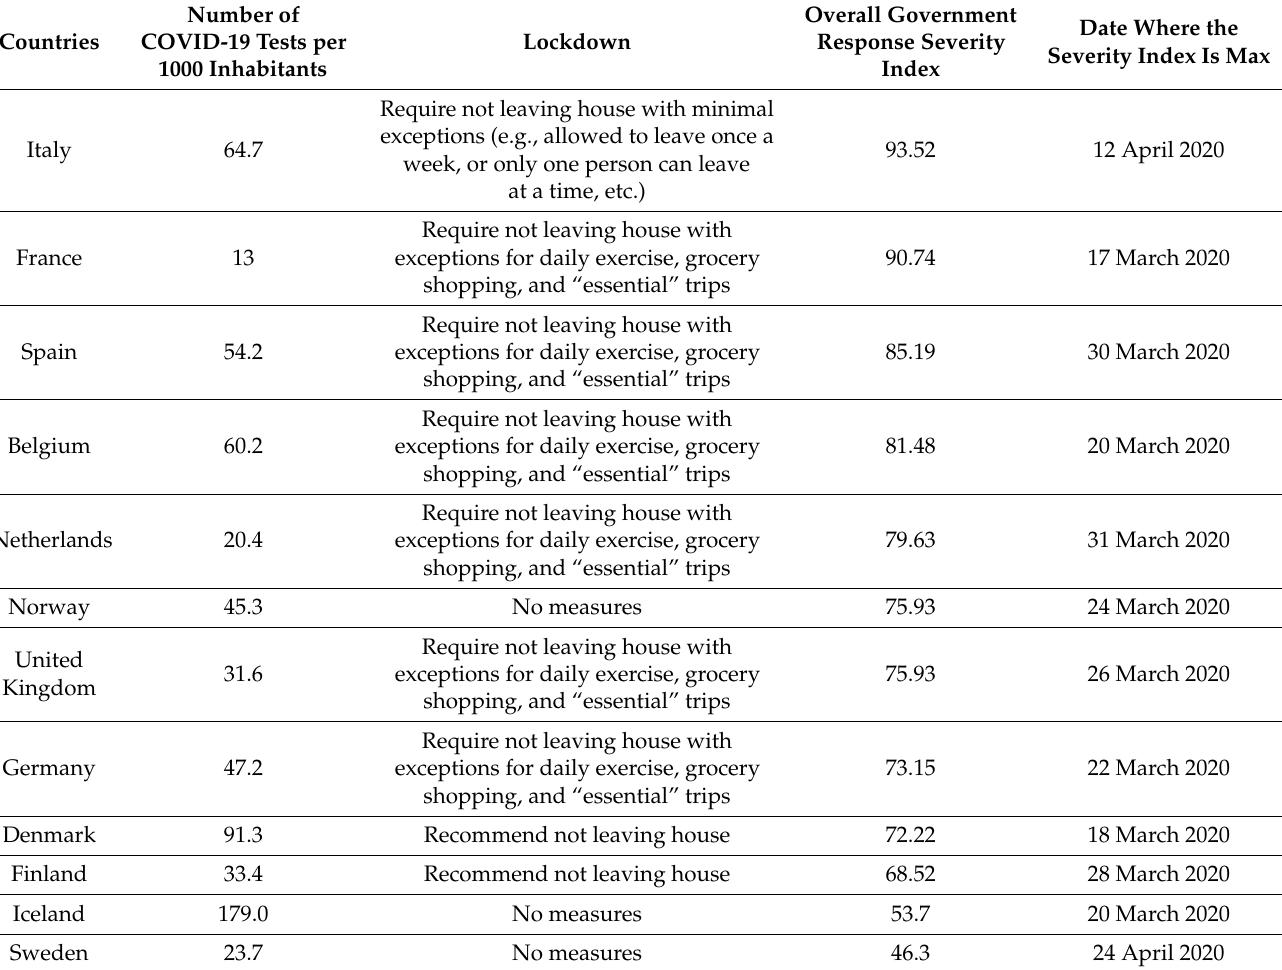
Table 1. Comparison of government policies against